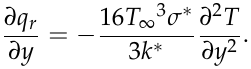
Table 2. The nanoparticles and base fluid properties [37].